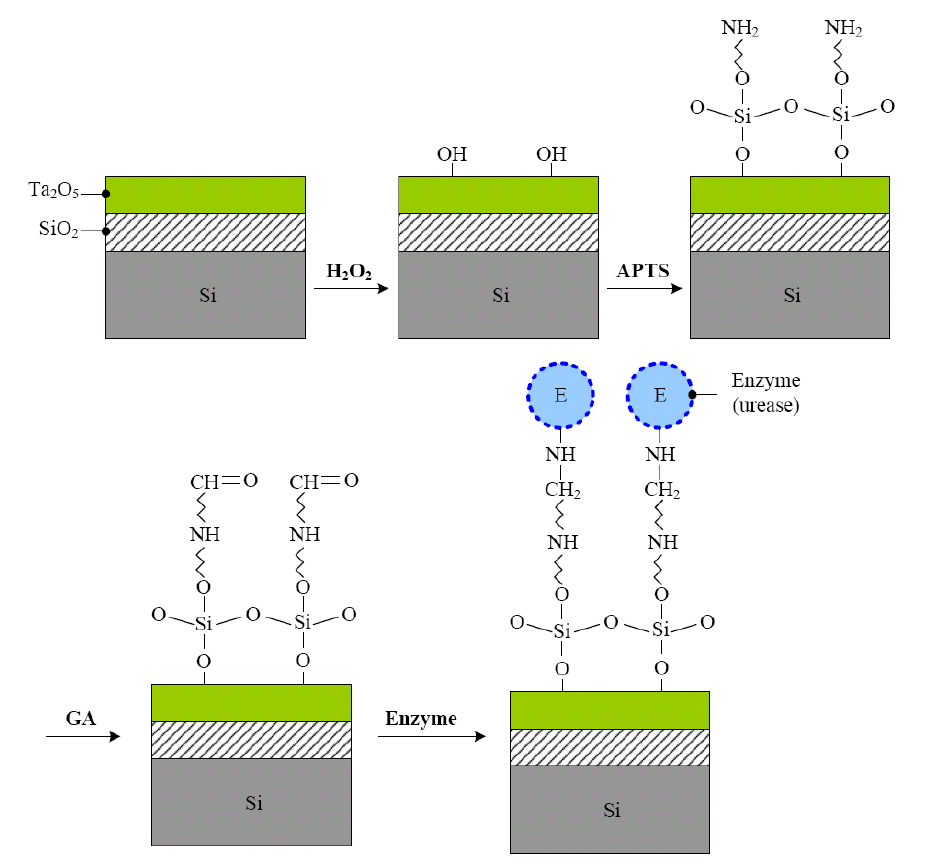
Figure 2. Schematic of covalent bonding process flow of urea-EnFET based on Ta sensing